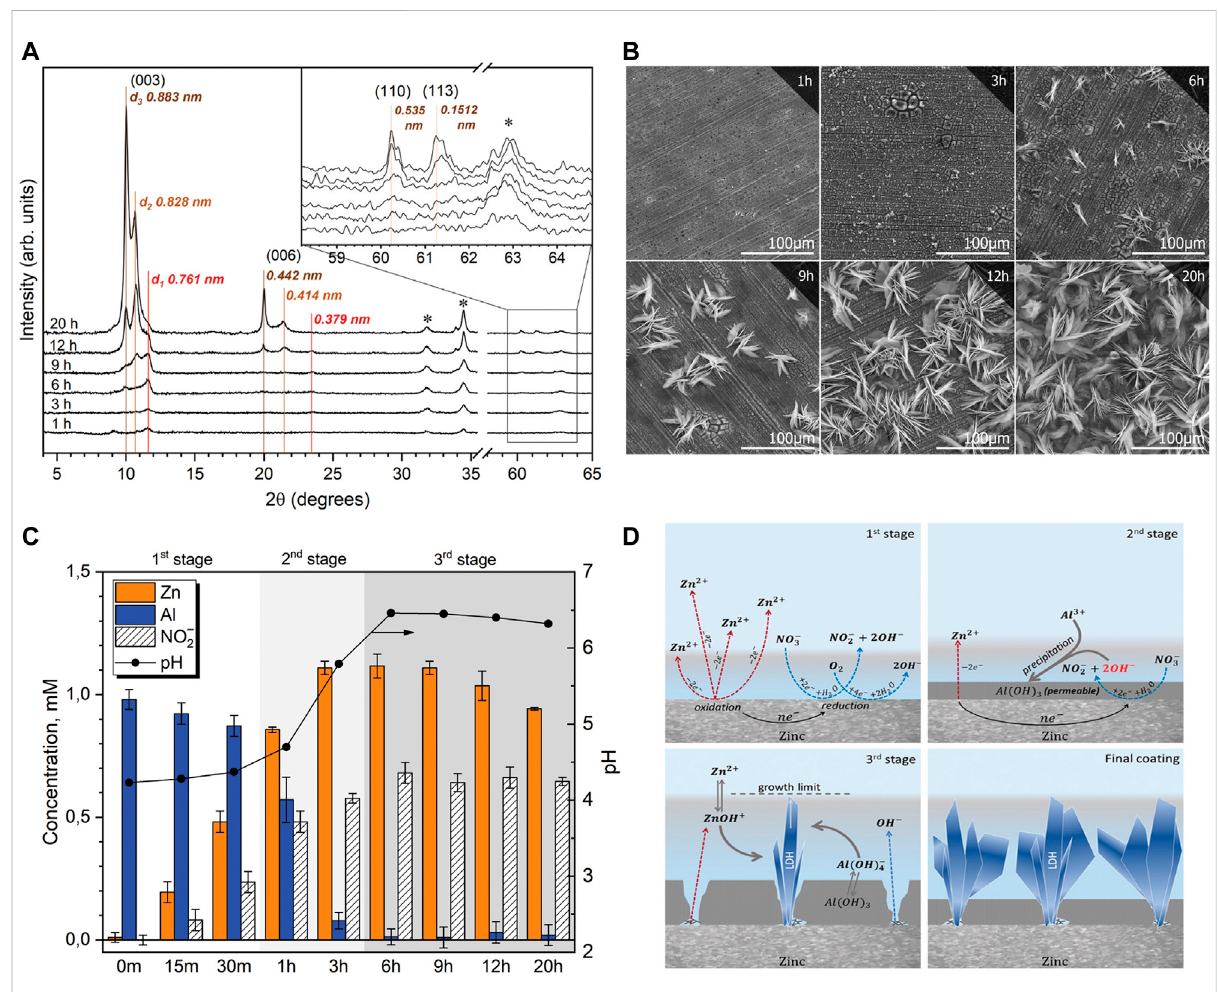
FIGURE 6 XRDpatterns (A) andSEMmicrographs (B) takenfromzincsurfaceafterdifferentsynthesistimes;kineticsofevolution (C) ofAl 3+ ,Zn 2+ andNO 2 − concentrations in the solution, and scheme (D) of the LDH growth mechanism. Reproduced from (Mikhailau et al., 2019) with permission from the Royal Society of